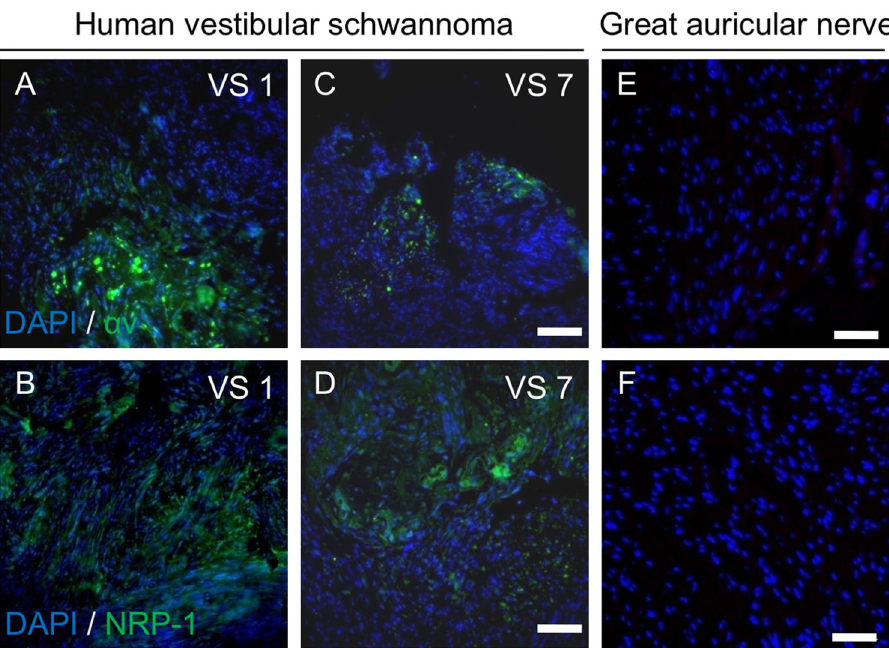
Figure 4. Expression of receptors for iRGD targeting in human VS specimens and healthy nerve controls. Immunofluorescence images of formalin-fixed, paraffin-embedded histological sections of human vestibular schwannomas ( A – D ) and great auricular nerve (GAN) controls ( E , F ). Top row , green represents α v integrin expression. Cell nuclei are counterstained with DAPI (pseudocolored blue). Scale bar, 100 μ m.